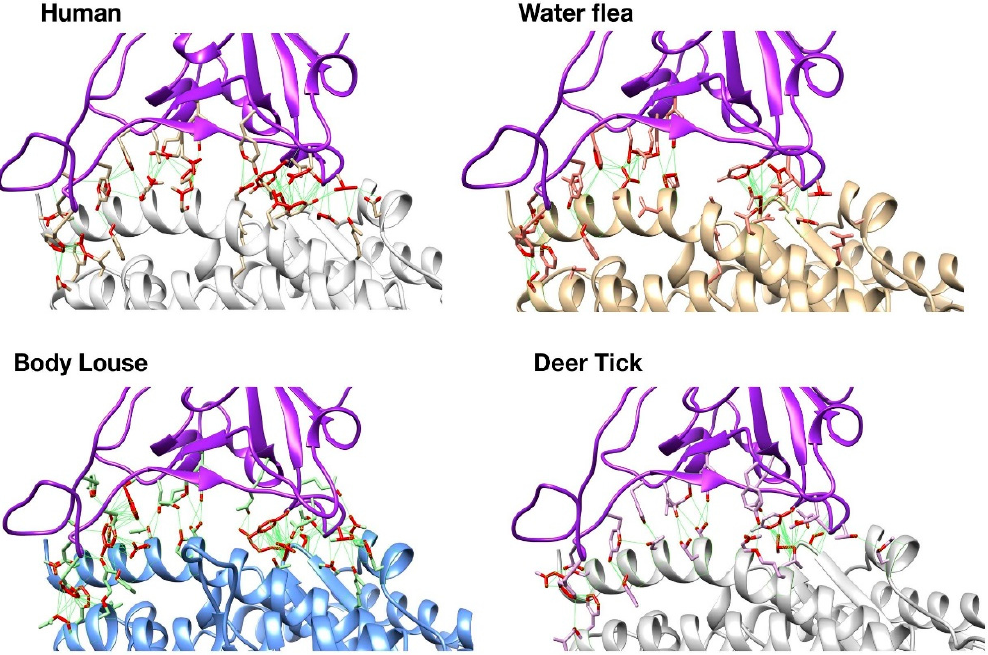
Figure 2. Structures of human and modelled ectoparasite SARS-CoV-2 S-protein: ACE complexes.